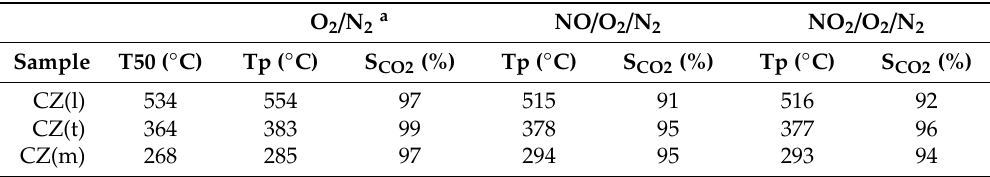
Table 3. Activity and selectivity results from TGA and TPO experiments.